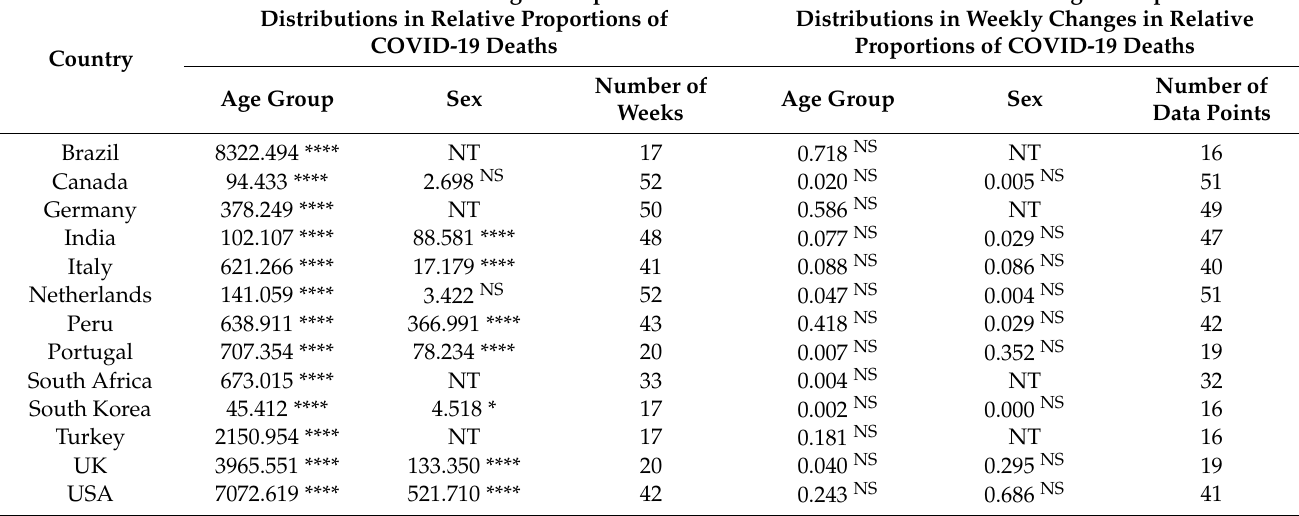
USA Values in Table 3 are F values. p values are indicated by * for <0.05, and **** for <0.0001. NS for not significant, NT for not